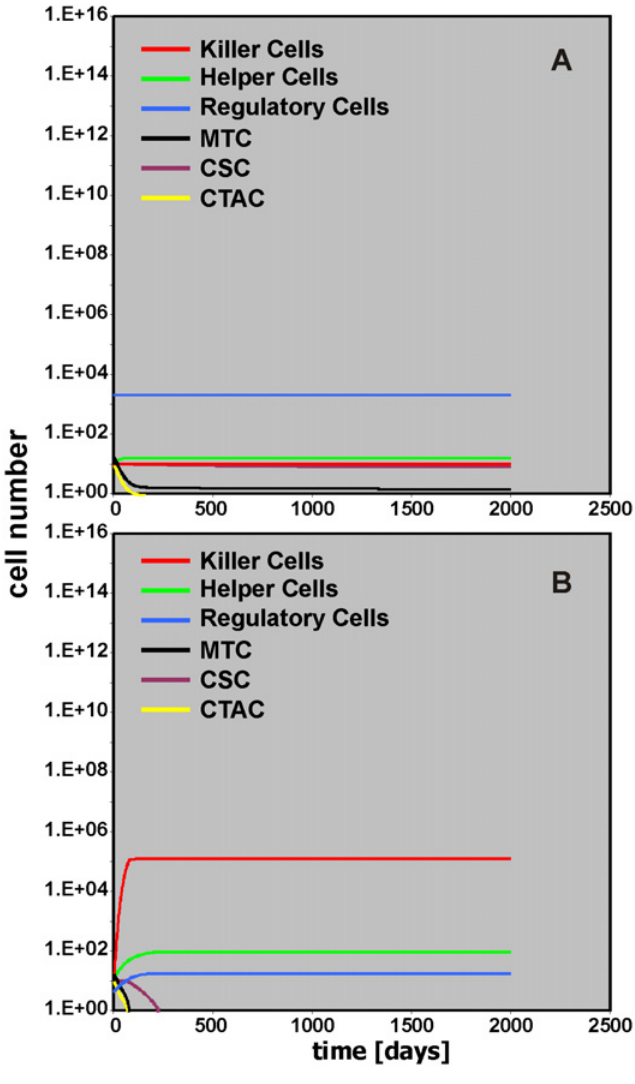
Fig 6. Impact of “ Regulatory Cells ” on tumor control. In this simulation the starting number of “ Regulatory Cells ” was increased (A; Initial Regulatory Cells = 2000) or decreased (B; Initial Regulatory Cells = 4). Efficient tumor control occurs either due to suppression of “ Helper Cells ” (A) or increased activity of “ Killer Cells ” (B).